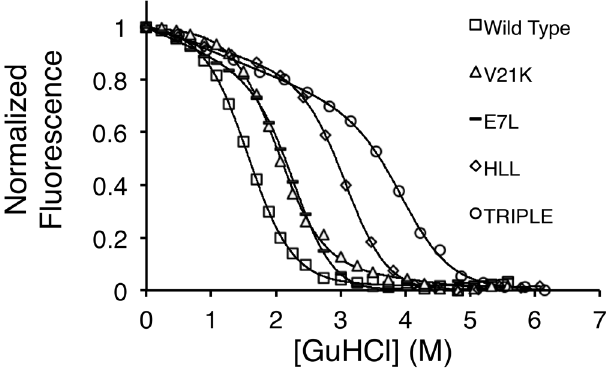
Fig 4. Representative guanidine denaturation curves of proteins. AbpSH3 WT (open square), V21K (open triangle), E7L (line), Triple (open circle) and HLL (open diamond) denaturation monitored by tryptophan fluorescence emission at 330 nm. Fluorescence values are expressed as a fraction of the total change. The lines joining the points in each graph are theoretical fits to the data based on Eq 4 and the resultant thermodynamic parameters are shown in Table 2.